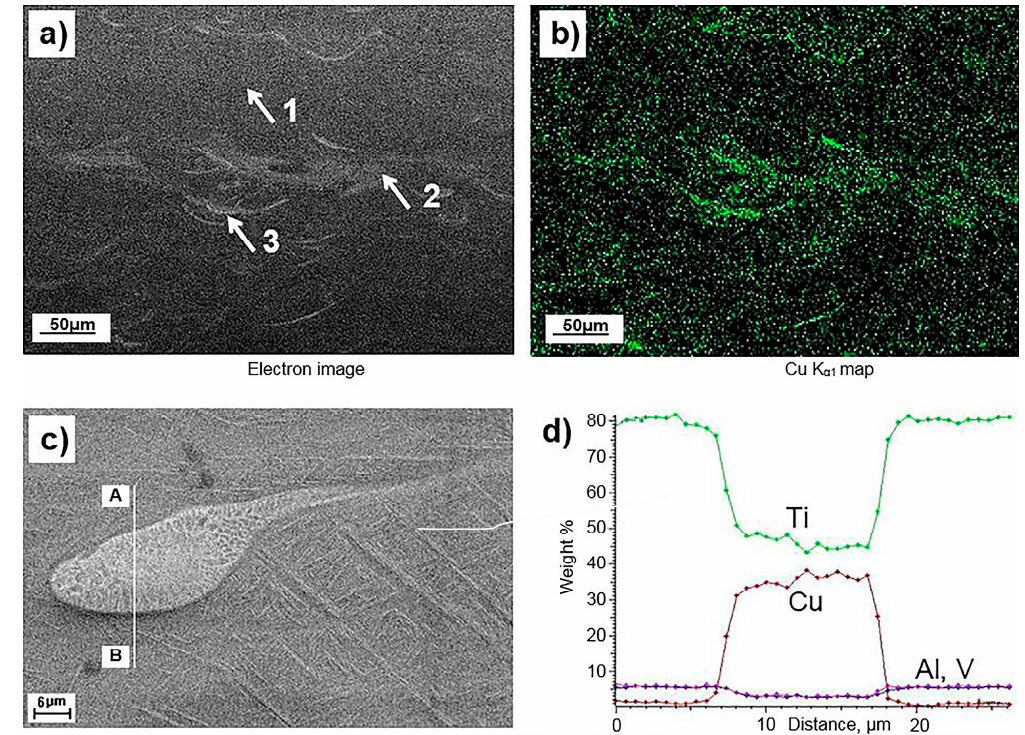
Figure 3. Cu-enriched regions in LPBF Ti6Al4V (ELI)-1 at % Cu alloy: ( a ) back scattered electron image; ( b ) CuK α SEM-EDS map of a cross-section made along building direction; ( c ) Cu-rich droplet-like area and ( d ) elemental concentration profiles in wt % of Ti, Al, V and Cu in the Cu-rich area illustrated in ( c ) obtained along line AB. Arrows indicate typical microstructures, 1—regular grey martensitic, 2—bright-gray martensitic, 3—bright droplet-like regions.